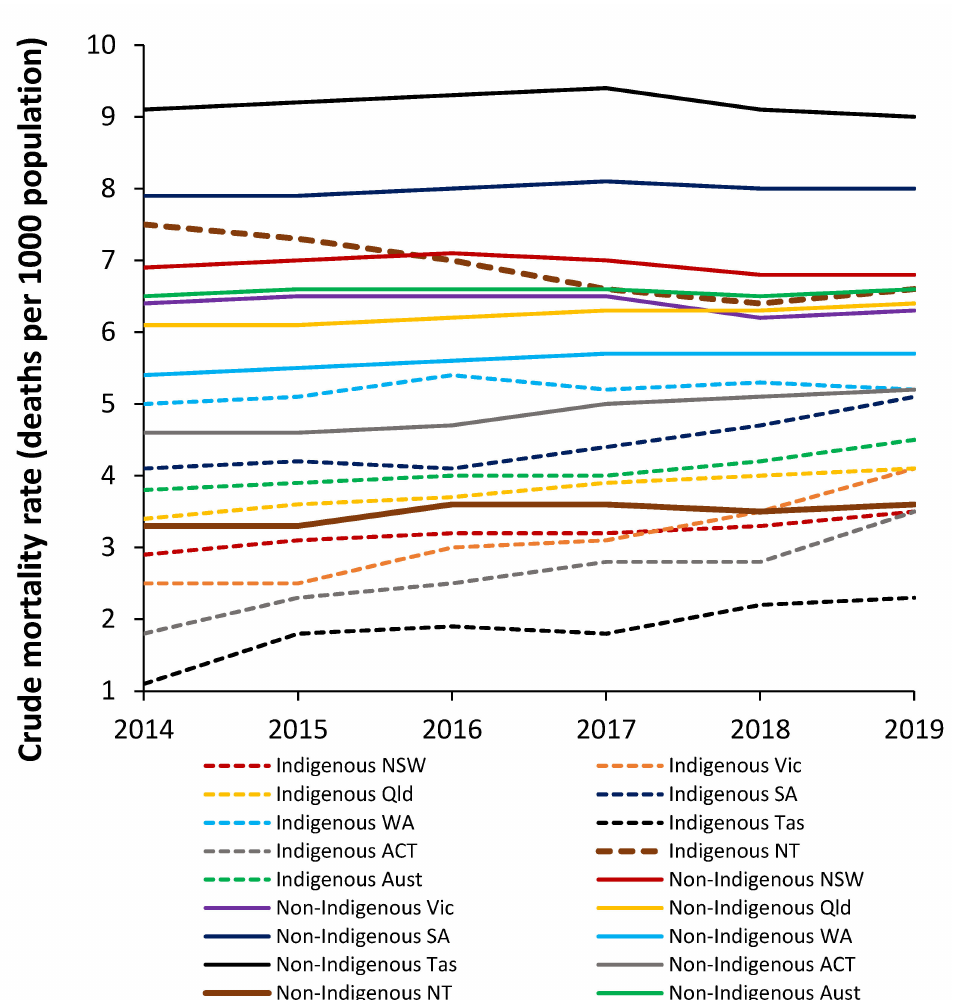
Figure A2. Crude mortality rate (deaths per 1000 population) for Indigenous versus non-Indigenous people in Australian states, 2014 to 2019